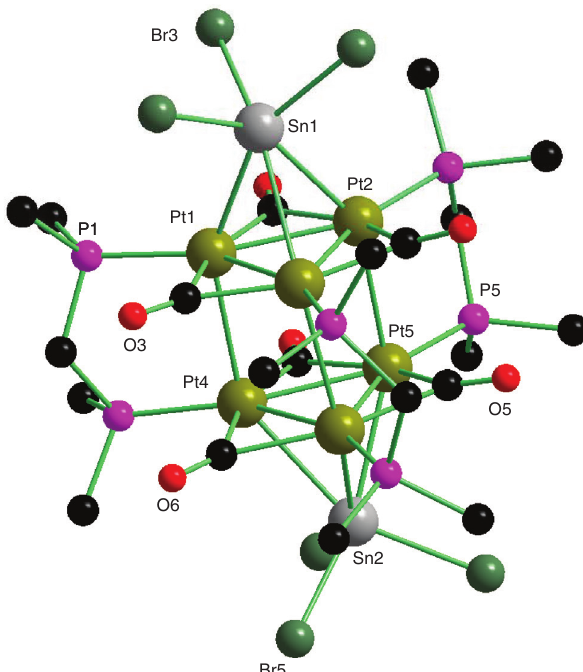
Figure 2 Simplified view of the molecular structure (diamond) of